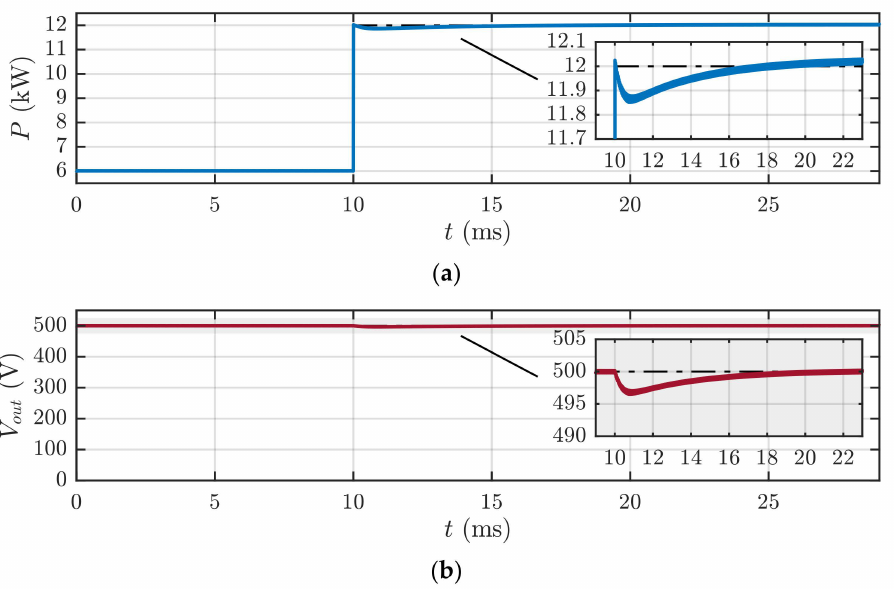
Figure 14. Output power ( a ) and output voltage ( b ) change on the DC bus when load changes from 6 kW to 12 kW in comparison with the same parameters of the comparative article [35].